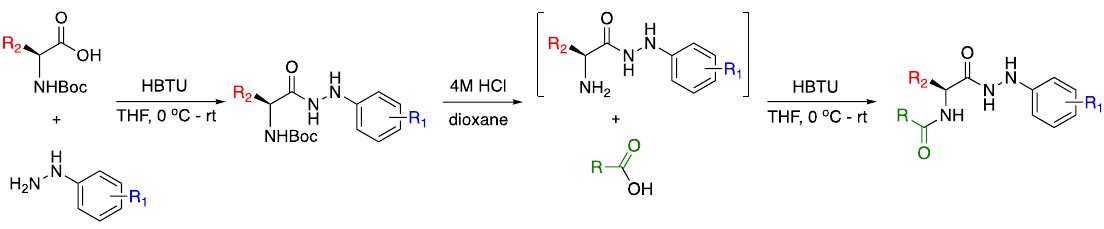
Scheme 1: Synthesis of amino acid hydrazides and the desired substituted